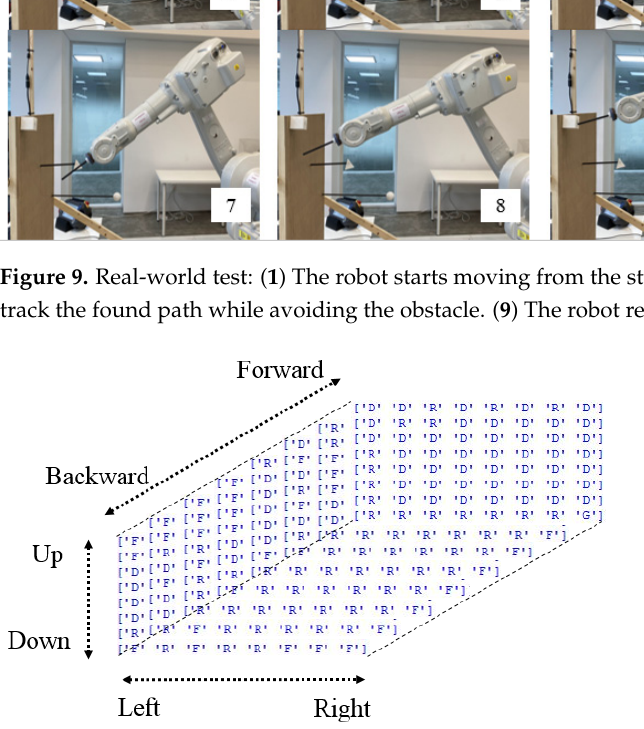
Figure 10. The optimal policy of each state (cell).